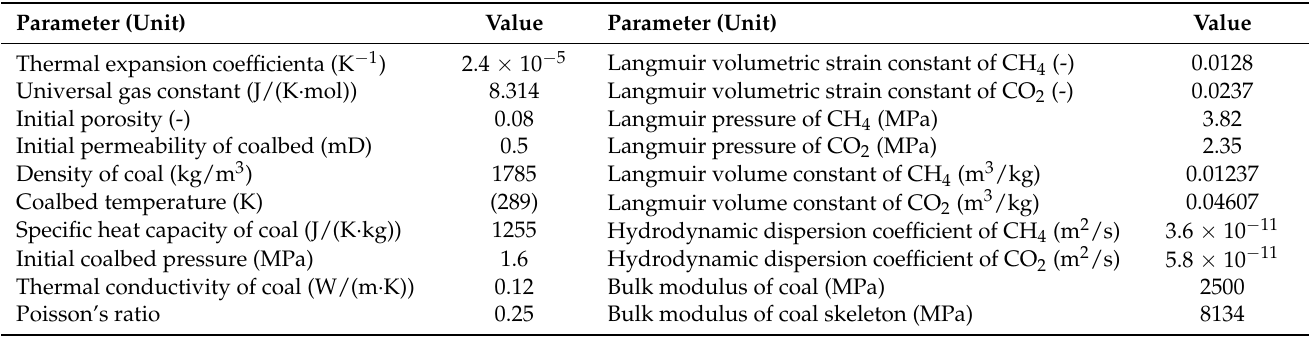
Table 5. Numerical simulation core parameters (refer to CSEMP project).